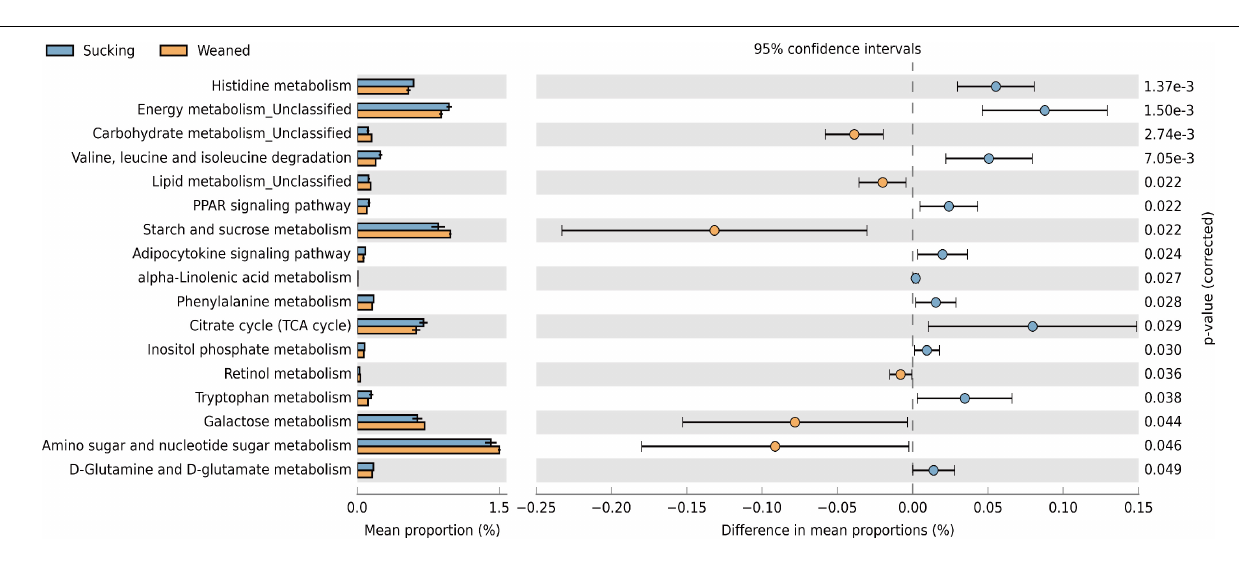
FIGURE 10 | Predictive functional profiles generated from 16S rRNA marker gene sequences using PICRUSt. Functional profiles were generated based on KEGG ortholog prediction and collapsed into higher pathways (L3), according to the KEGG pathway